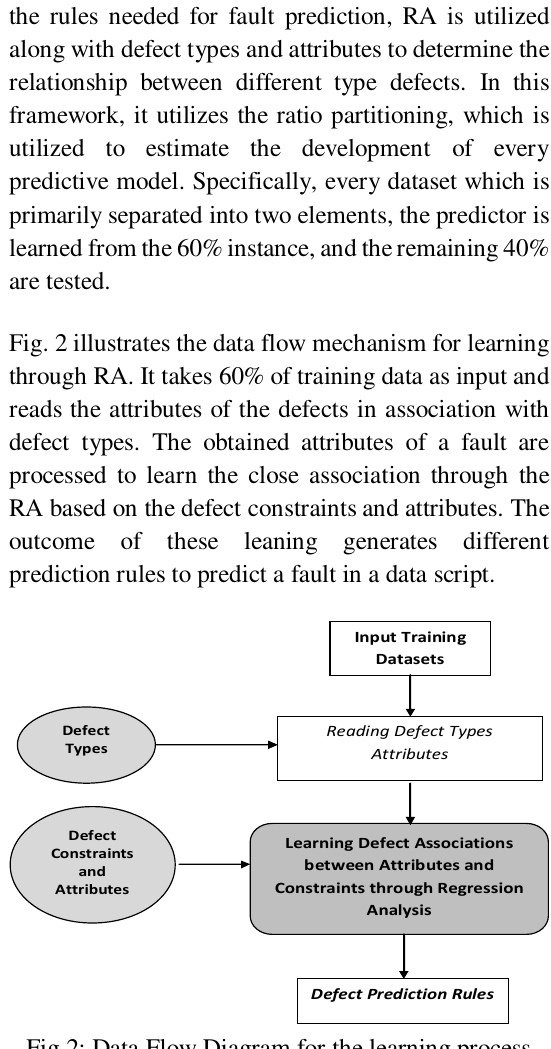
Fig.2: Data Flow Diagram for the learning process utilizing RA